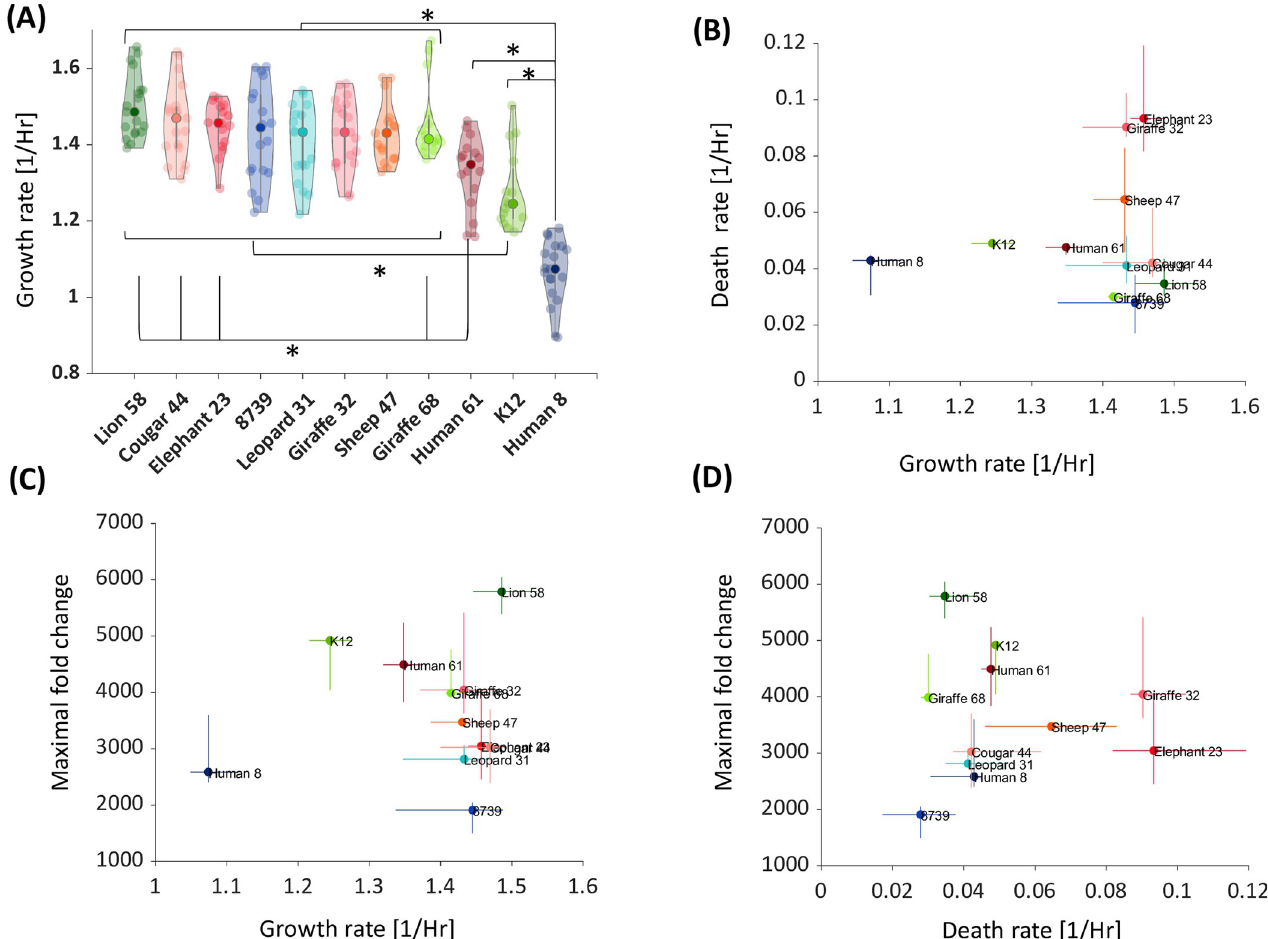
Fig 2. Maximal growth rate and death rate do not account for strain variability. (A) Violin plot of the maximal growth rate distribution. The bold dots represent the median maximal growth rate. The other dots represent the different samples. The asterisks denote distributions that are different according to the Kolmogorov-Smirnoff test with a p-value < 0.05. (B) Death rate vs. maximal growth rate. The colored dots represent the median rates. The error bars are the 34 and 66 percentiles. Maximal growth rate and death rate have no significant correlation between them (Pearson: ρ = 0.13, p-value = 0.17). There is also no significant correlation between (C) Maximal fold change (FC) and growth rate (Pearson: ρ = 0.084, p-value = 0.81). (D) Maximal FC and death rate (Pearson: ρ = 0.011, p-value =